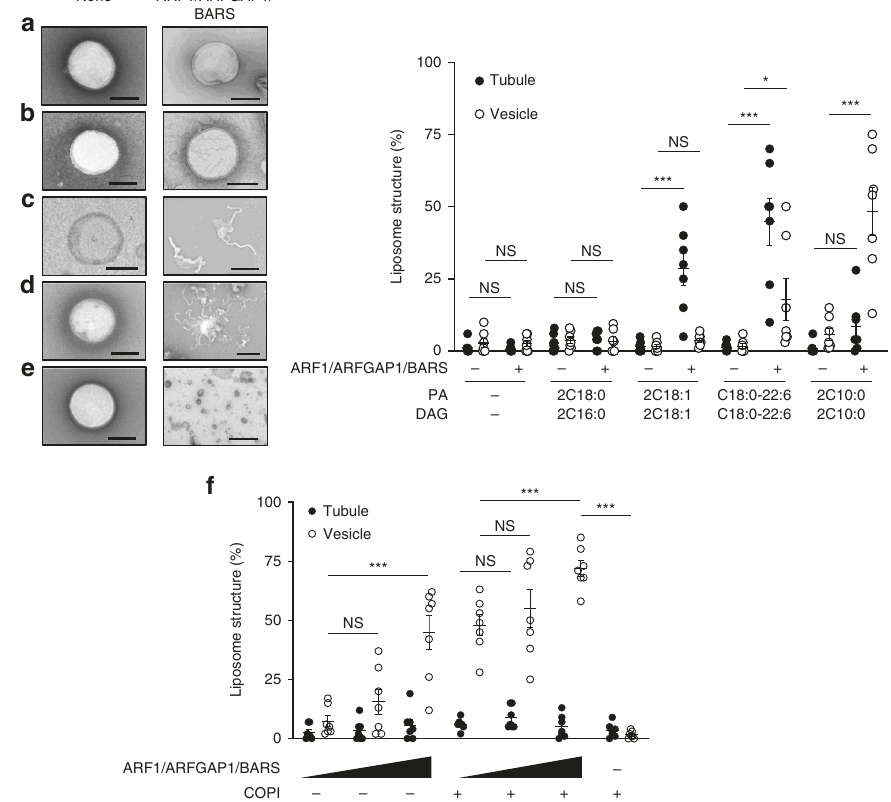
Fig. 6 Reconstituting vesiculation with liposomes. Quantitative data are shown as mean ± s.e.m. Signi fi cance was tested using the two-tailed Student ’ s t test, * P < 0.05, *** P < 0.0001, NS P > 0.05. Golgi-like liposomes were generated with additional lipids incorporated as follows: a none, b phosphatidic acid (PA) (2C18:0) and diacylglycerol (DAG) (2C16:0), c PA (2C18:1) and DAG (2C18:1), d PA (C18:0/C22:6) and DAG (C18:0/C22:6), and e PA (2C10:0) and DAG (2C10:0). Liposomes were then incubated with Coat Protein I (COPI) fi ssion factors as indicated, followed by electron microscopic (EM) examination. Representative images are shown on left, bar = 250 nm. The degrees of liposome tubulation and vesiculation are quanti fi ed on right; n = 7 independent experiments. f Golgi-like liposomes with PA (2C10:0) and DAG (2C10:0) were incubated with increasing levels of COPI fi ssion factors (ARF1, ARFGAP1, and BARS) and either with or without coatomer, followed by EM examination to assess the degree of liposome tubulation and vesiculation; n = 3 independent experiments. Source data are provided as a Source Data fi le